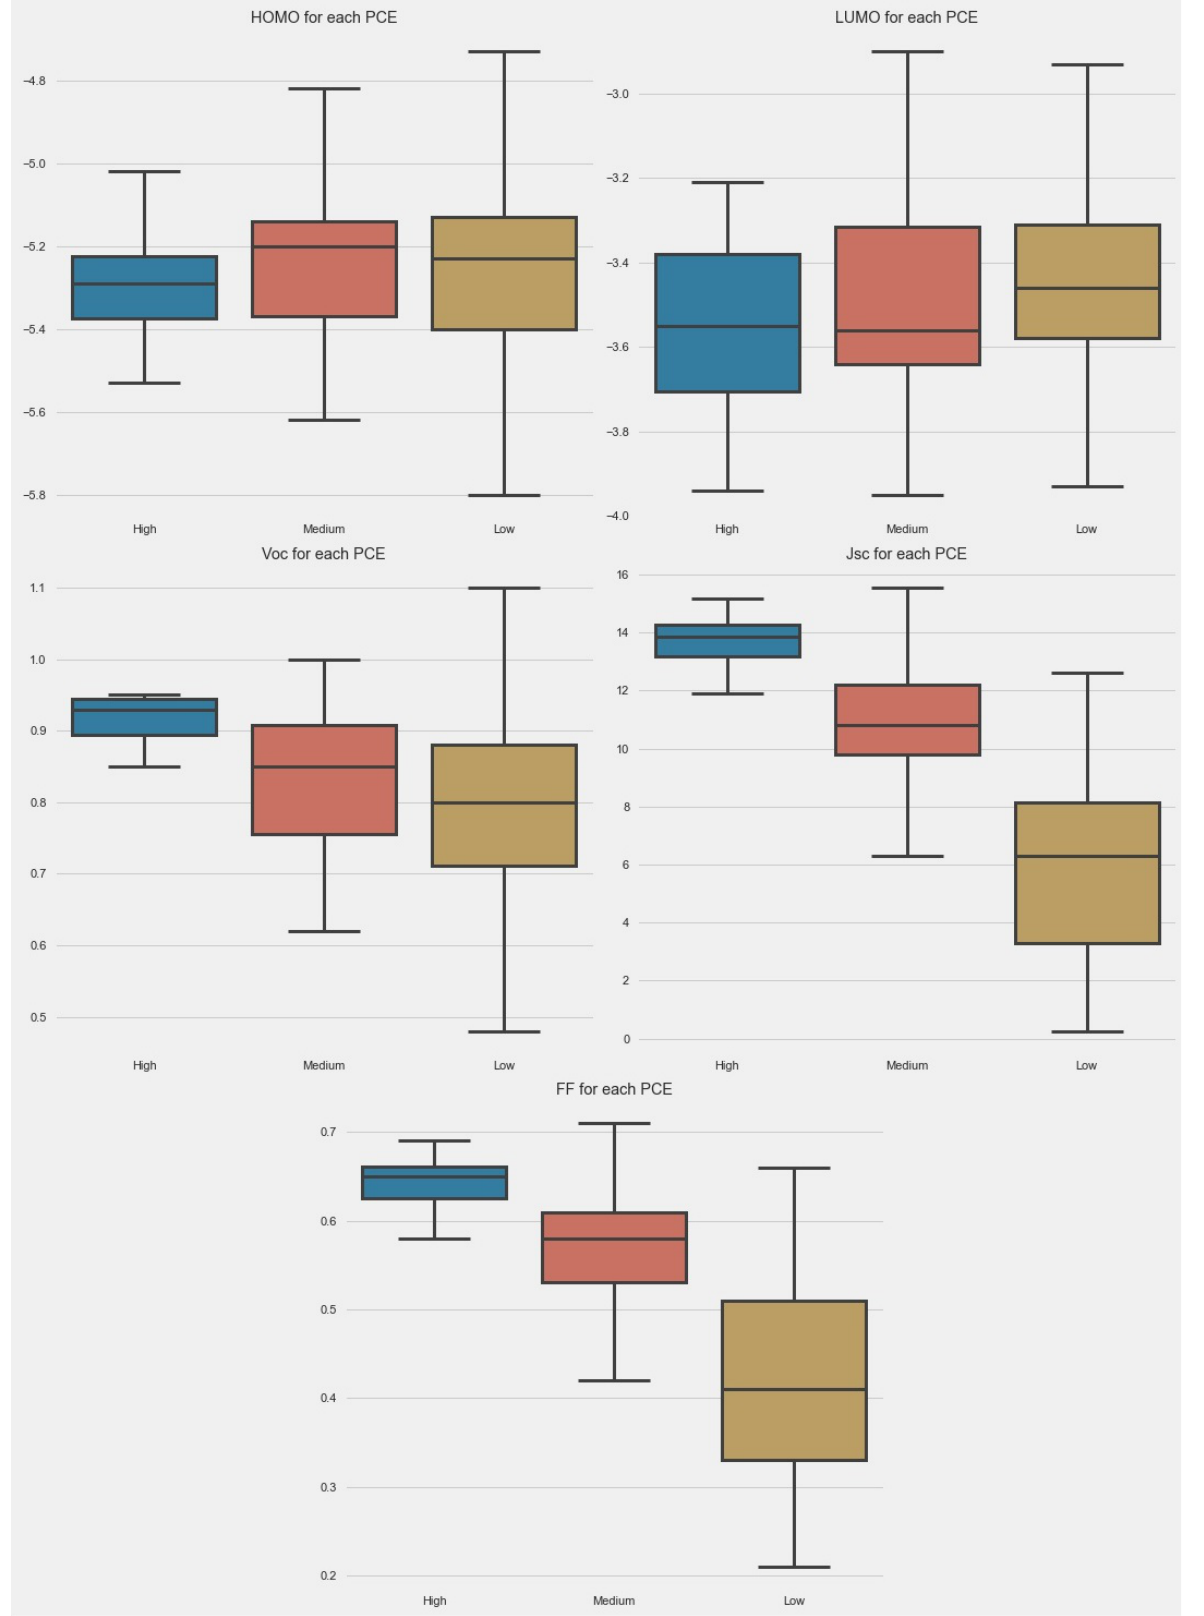
Figure 3. Box plot of parameters in dataset.